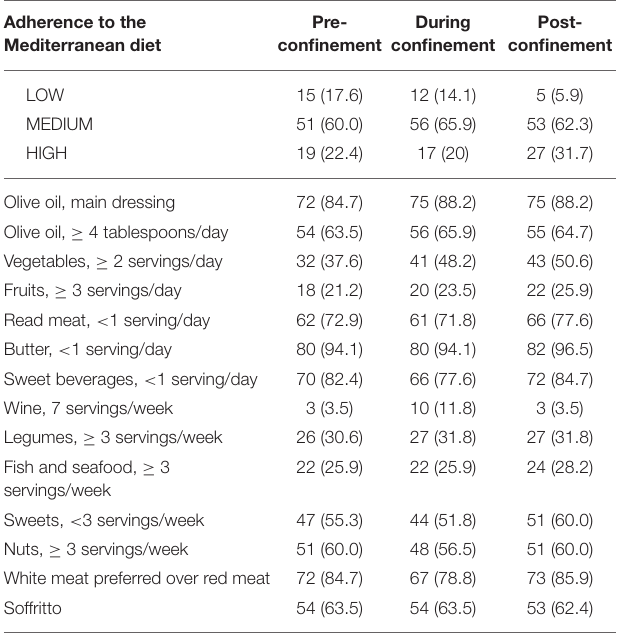
TABLE 3 | Adherence to the mediterranean diet and positive answers to the Mediterranean Diet Adherence Screener (MEDAS) questionnaire. Adherence to the Mediterranean